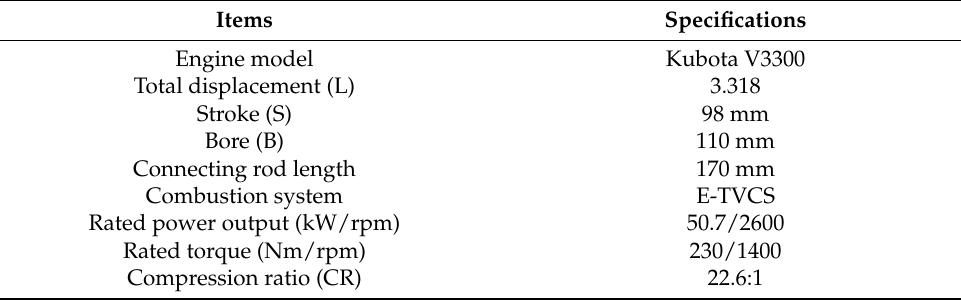
Table 3. Test engine specifications .